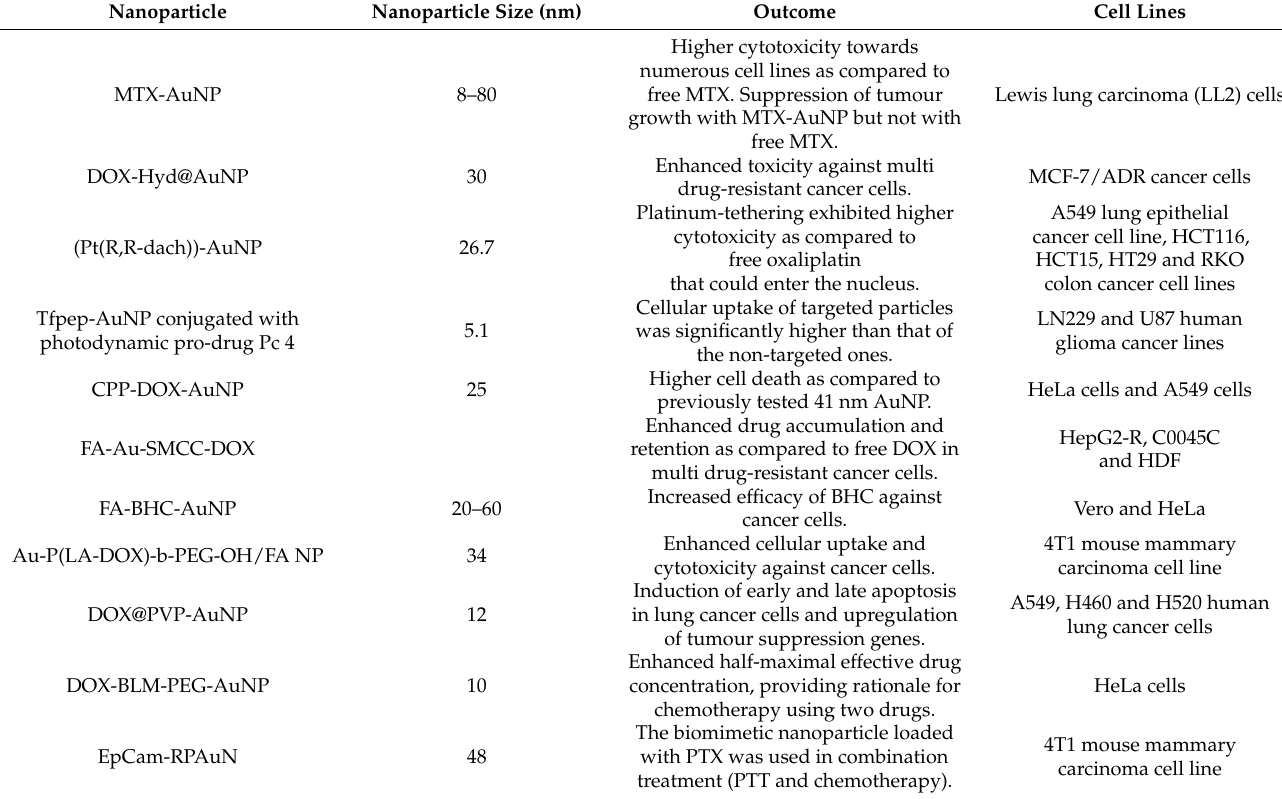
Table 1. Application of gold NPs in drug delivery. Reproduced with permission from